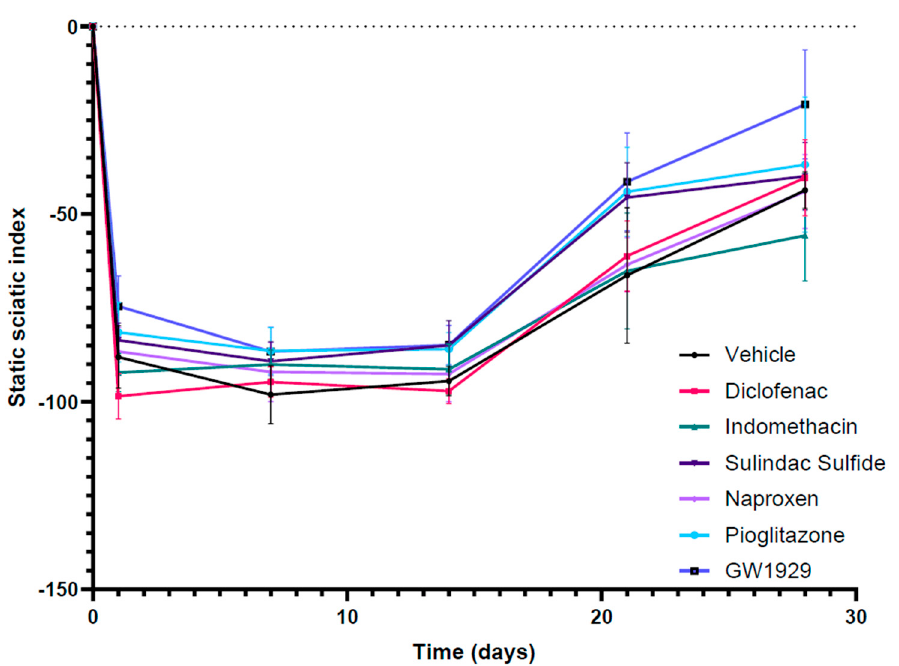
Figure 4. Hind paw images were used to conduct SSI quantitation in contralateral uninjured and injured sciatic nerves weekly until the 28-day endpoint. An initial loss of function can be seen immediately after the crush injury with recovery seen in all groups returning towards the baseline by 28 days post injury. N = 6, means ± SEM.